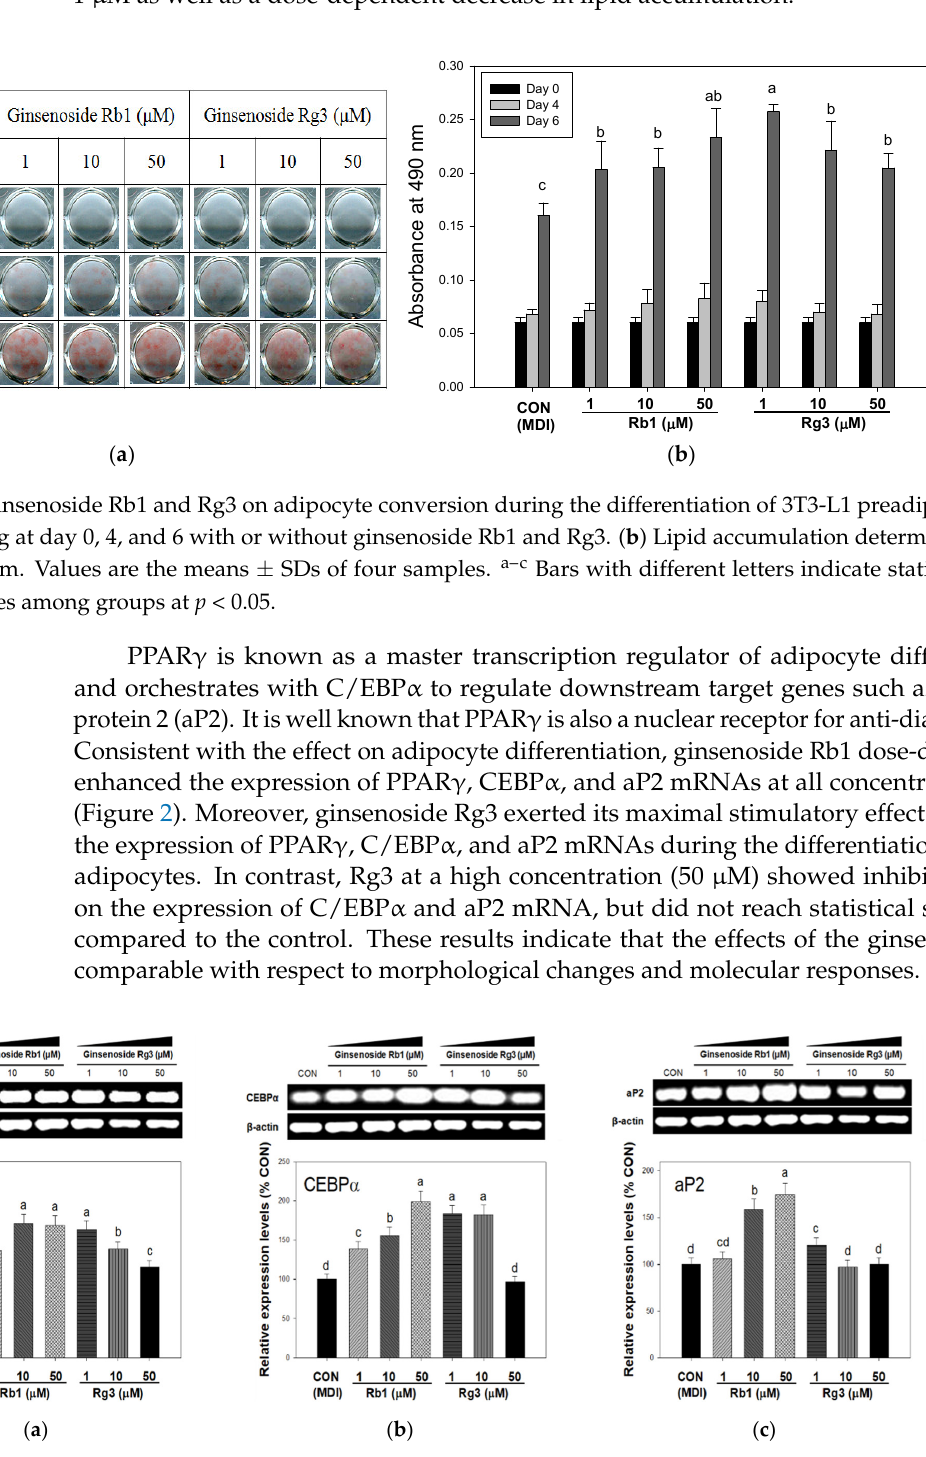
Figure 2. Changes in the expression of PPARγ, CEBPα, and aP2 mRNAs by ginsenosides Rb1 and Rg3 during the differentiation of 3T3-L1 preadipocytes. Values are the means ± SDs of four samples. a–d Bars with different letters indicate statistically significant differences among groups at p < 0.05.